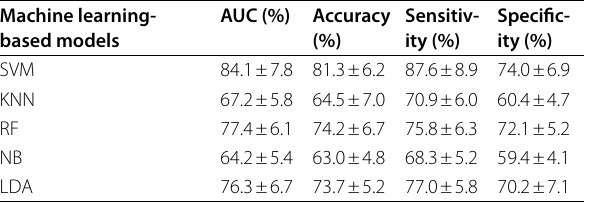
Table 2 Performance metrics from machine learning–based models Machine learning- based models